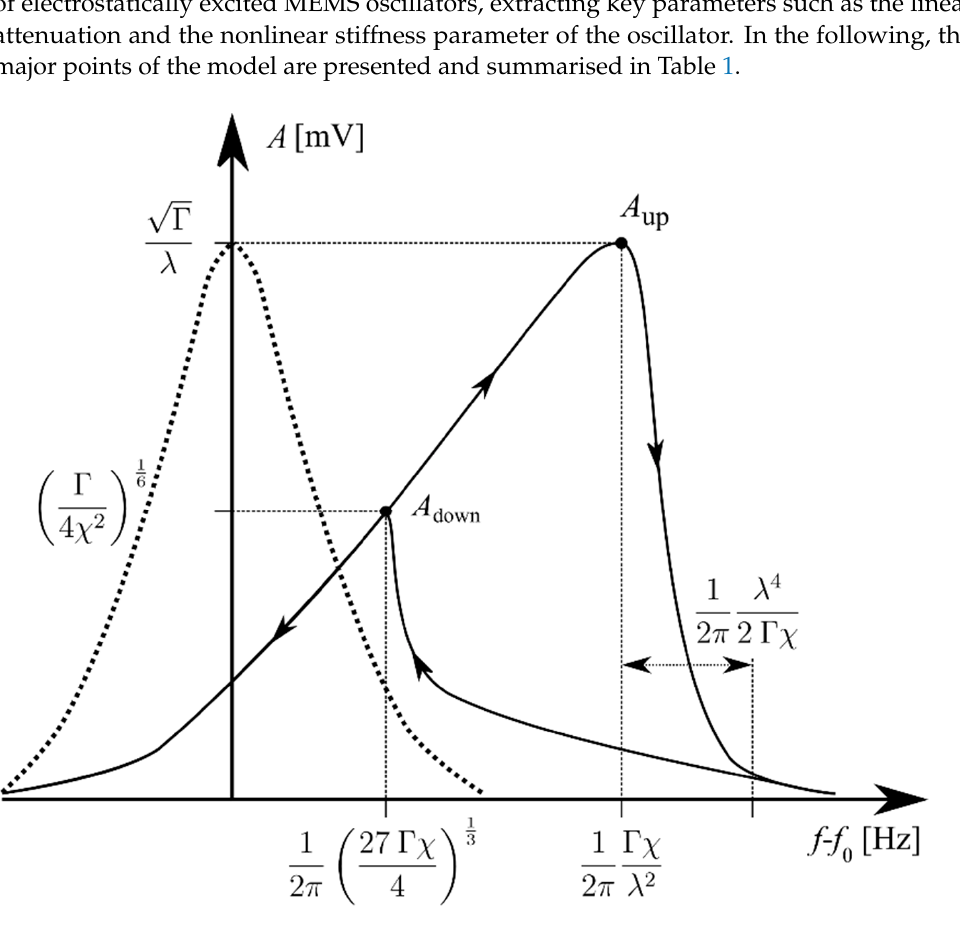
Figure 3. Amplitude versus the frequency shift for a damped harmonic oscillator (dotted line) and Duffing oscillator (solid line). The key parameters according to Ayela’s model are included [9].